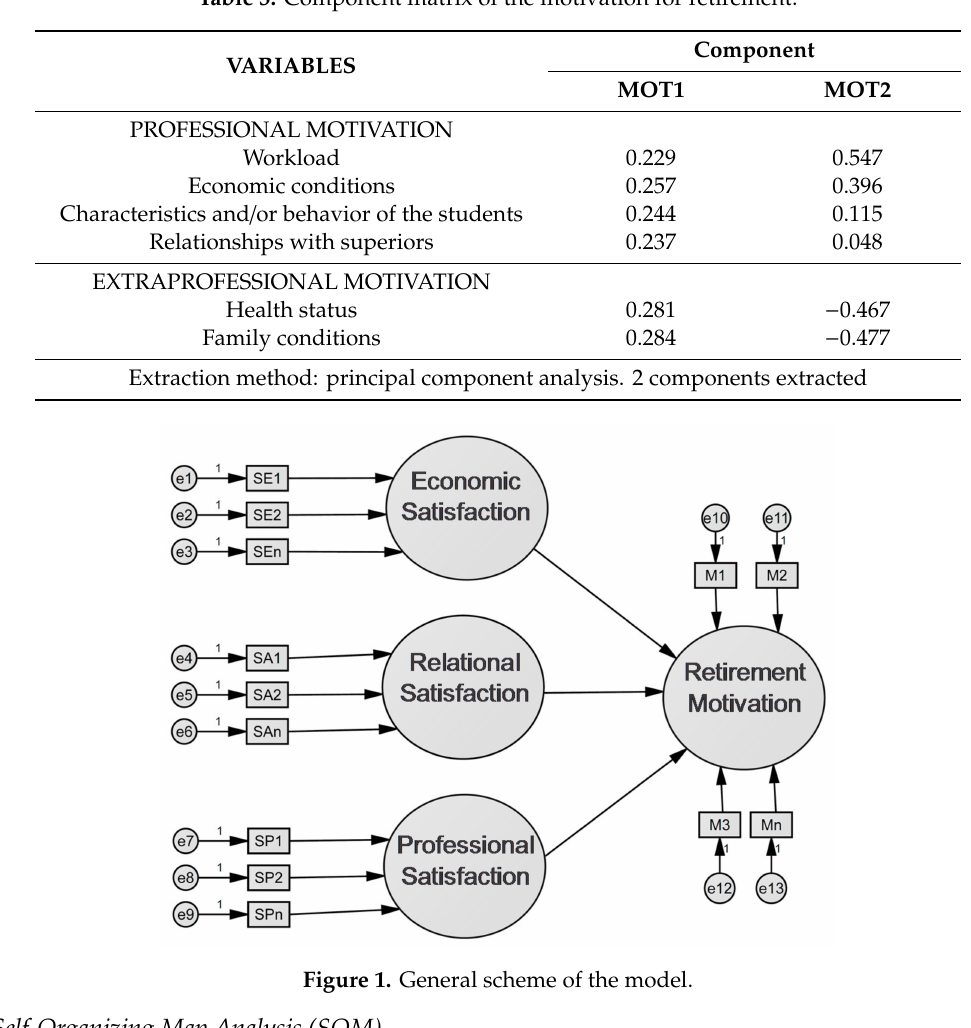
Table 3. Component matrix of the motivation for retirement.